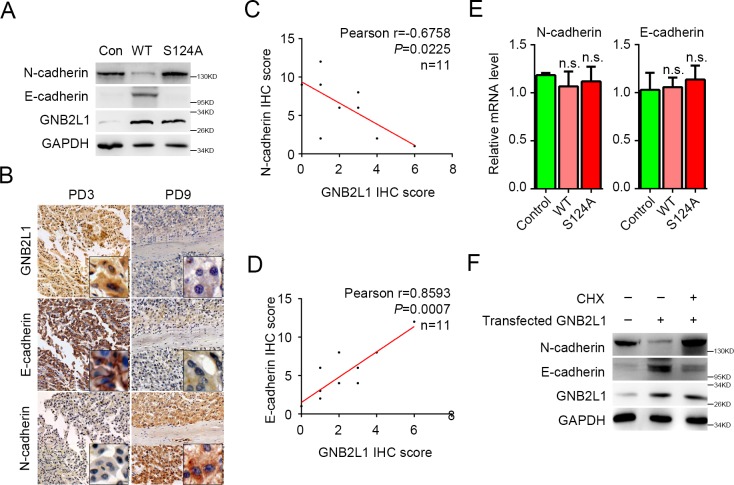
GNB2L1 and its O-GlcNAcylation regulated EMT in chemoresistance.(A) The protein levels of EMT-related markers, E-cadherin and N-cadherin were determined by WB in SGC-7901/DDP cells. (B-D) The changes of E-cadherin and N-cadherin in protein level were further confirmed in tumor tissues by IHC (B). The correlation between GNB2L1 and E-cadherin or N-cadherin in clinical chemoresistant gastric cancer cases was determined by IHC (C-D). Representative images (B) and statistical data (C-D) were shown. (E) Transcriptional alternation of E-cadherin was assessed in qPCR analysis. (F) The translation alternation of EMT-related proteins was determined in SGC-7901/DDP transfected with or without GNB2L1 via WB. And some cells were treated with CHX (50 μM) for 30 min. GAPDH was used as loading control. All experiments were repeated more than 3 times. PD, progressive disease (considered as chemoresistance); n.s., not significant.